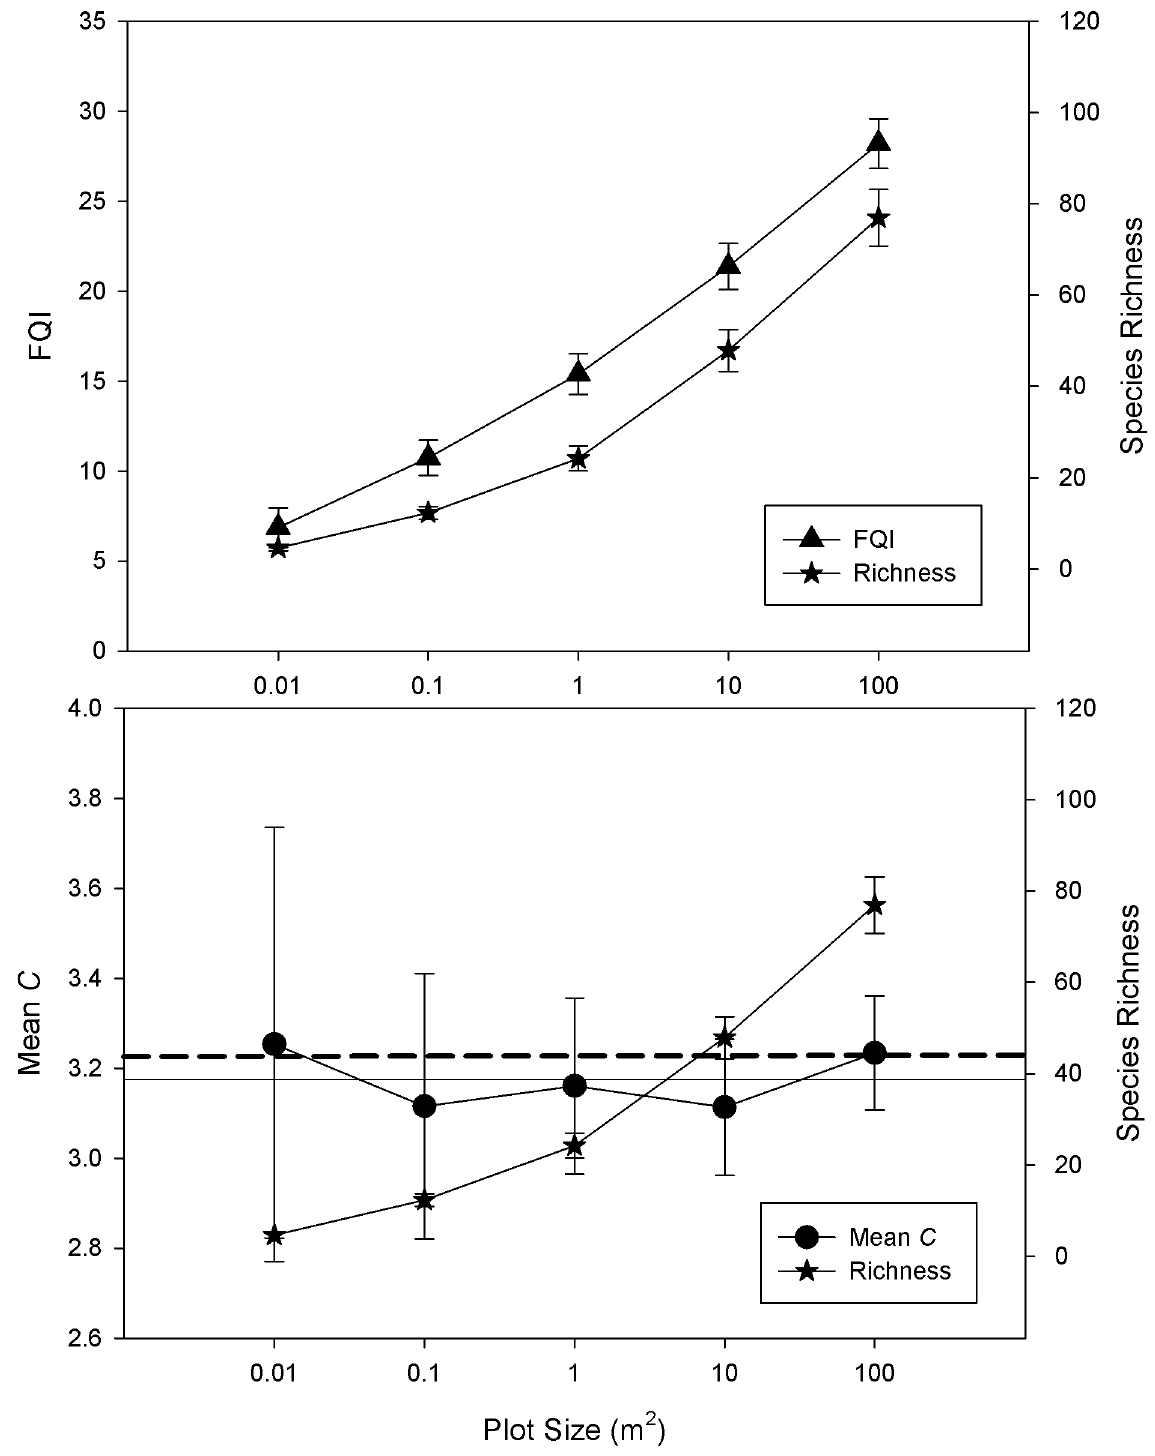
Fig 1. Average FQA and species richness across plot sizes ( ± 95% CI; N = 20). Horizontal lines provide reference levels for comparison. Solid horizontal line indicates average of Mean C points (0.01 ... 100), dashed horizontal line is the 100-m 2 plot value.